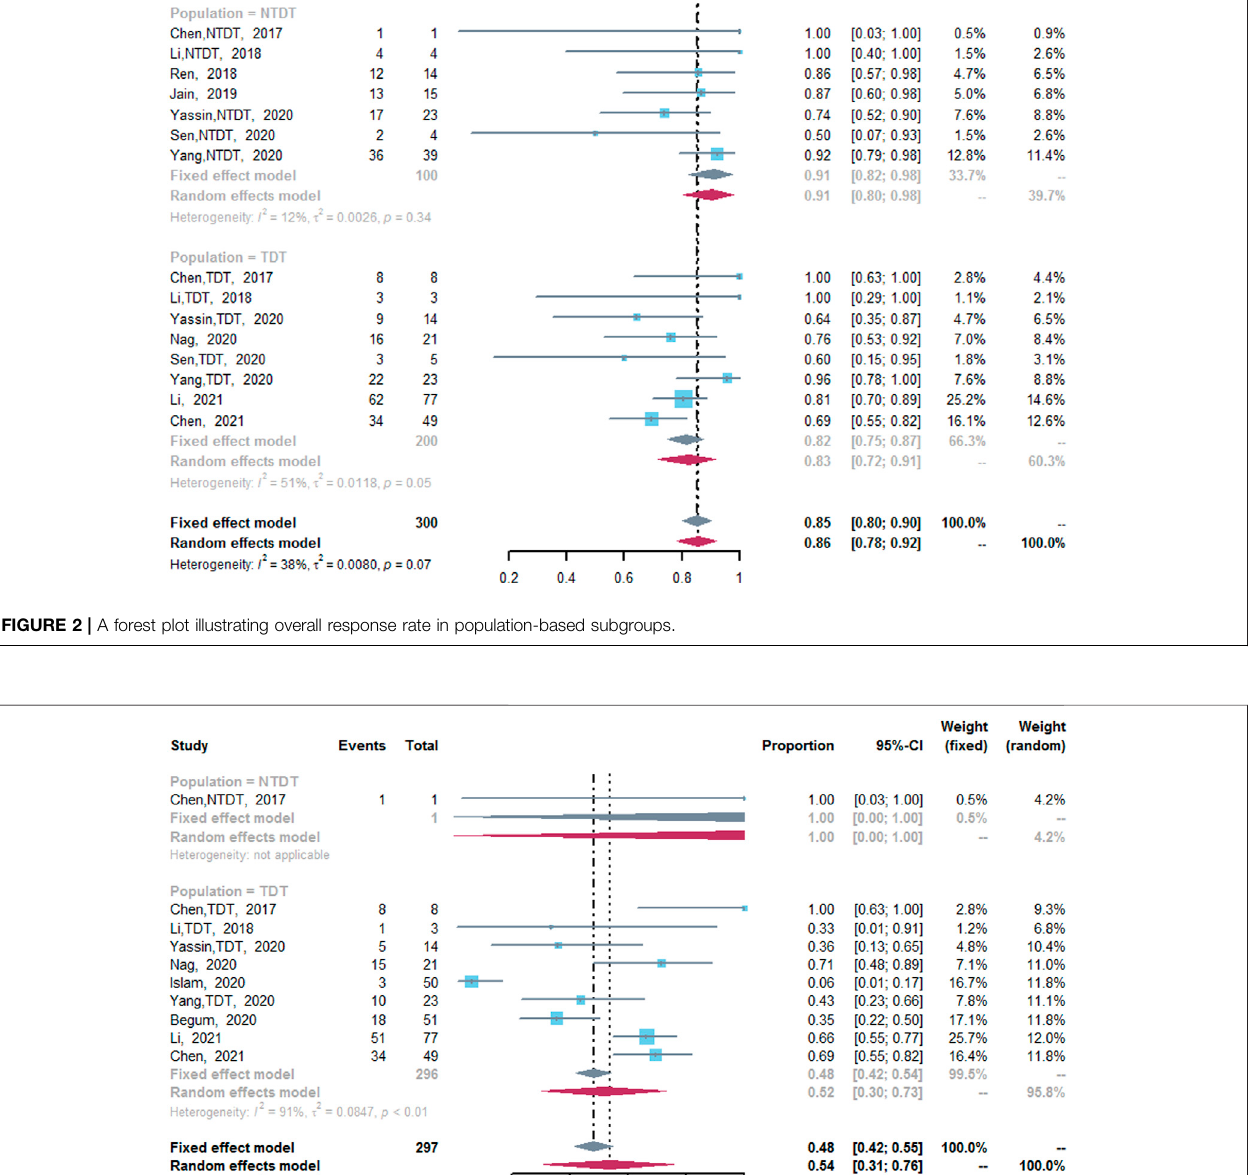
Frontiers in Pharmacology |